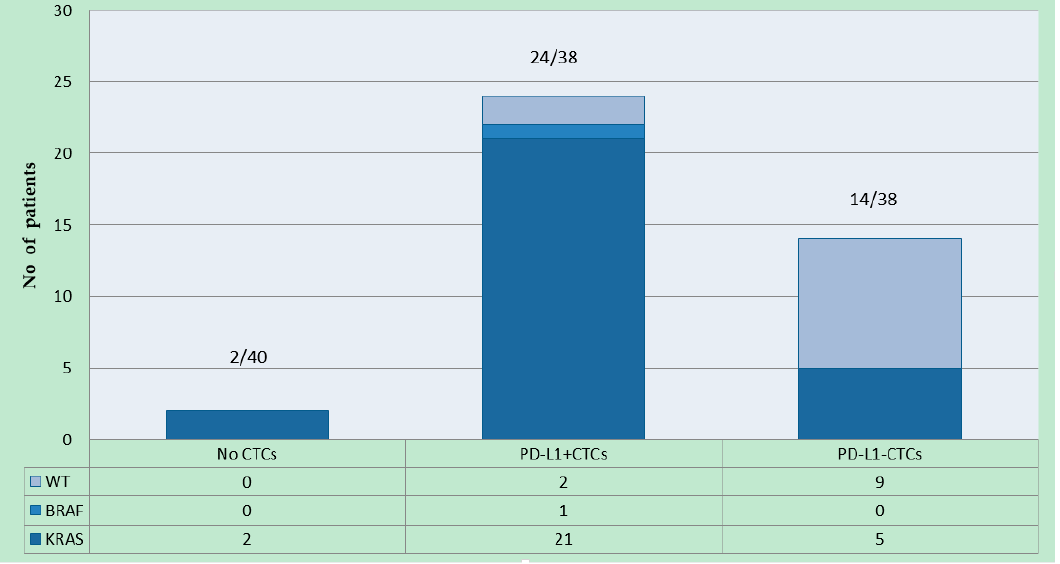
Figure 1. CTCs and PD-L1 expression on CTCs detected. Number of patients with only PD-L1 − , only PD-L1 + is reported in the chart below, in relation to KRAS and BRAF mutational status. PD-L1 was identified in 24 of the 38 patients (24/38, 63.2%) in whom CTCs were detected at baseline. The percentage of CTCs expressing PD-L1 varied widely, ranging between 5 and 94%. Of 24 patients with PD-L1 + CTCs, and 21 (21/24, 87.5%) with KRAS mutation, one patient (1/24, 4.2%) was identified with BRAF mutation and two (2/24, 8.3%) patients without mutations were identified. Fourteen patients, 5 (5/14, 35.7%) of whom had KRAS mutation, had PD-L1 − CTCs (Figure 2).